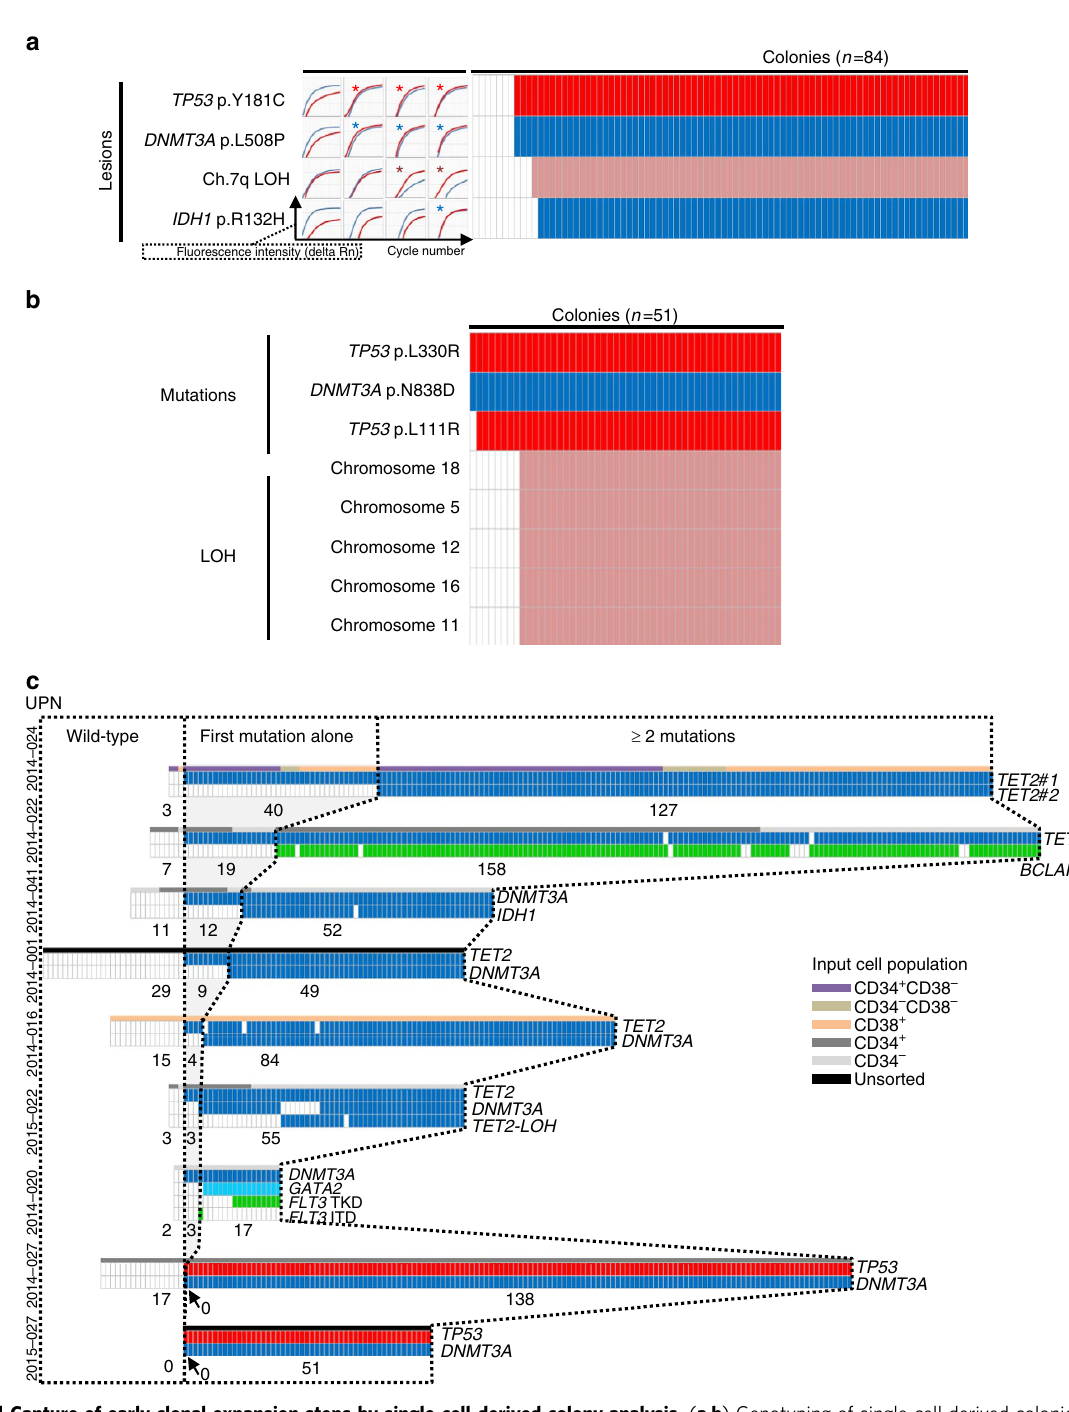
Figure 6 | Capture of early clonal expansion steps by single-cell-derived colony analysis. ( a , b ) Genotyping of single cell derived colonies from two de novo AMLs—UPN2014-027, ( a ) and UPN2015-027, ( b )—with concomitant DNMT3A and TP53 mutations, as in Fig. 1. Losses of heterozygosity (LOH) were detected using informative SNPs. Asterisks indicate mutant allele detection or LOH. ( c ) Mutational patterns of individual colonies from patients with early initiating lesions. Cell sorting strategies before culture are indicated above each table. Dotted lines separate wild-type colonies, colonies with one mutation, and colonies with Z 2 mutations/lesions. The number of colonies of each category is indicated below the